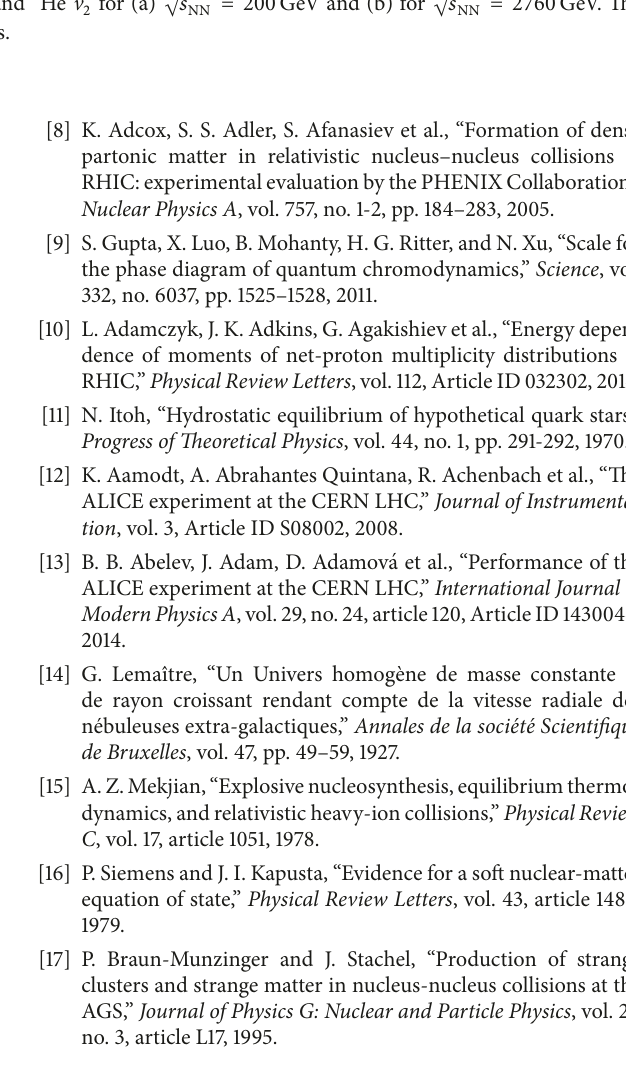
= 200 GeV and (b) for √𝑠 = 2760 GeV. The NN NN